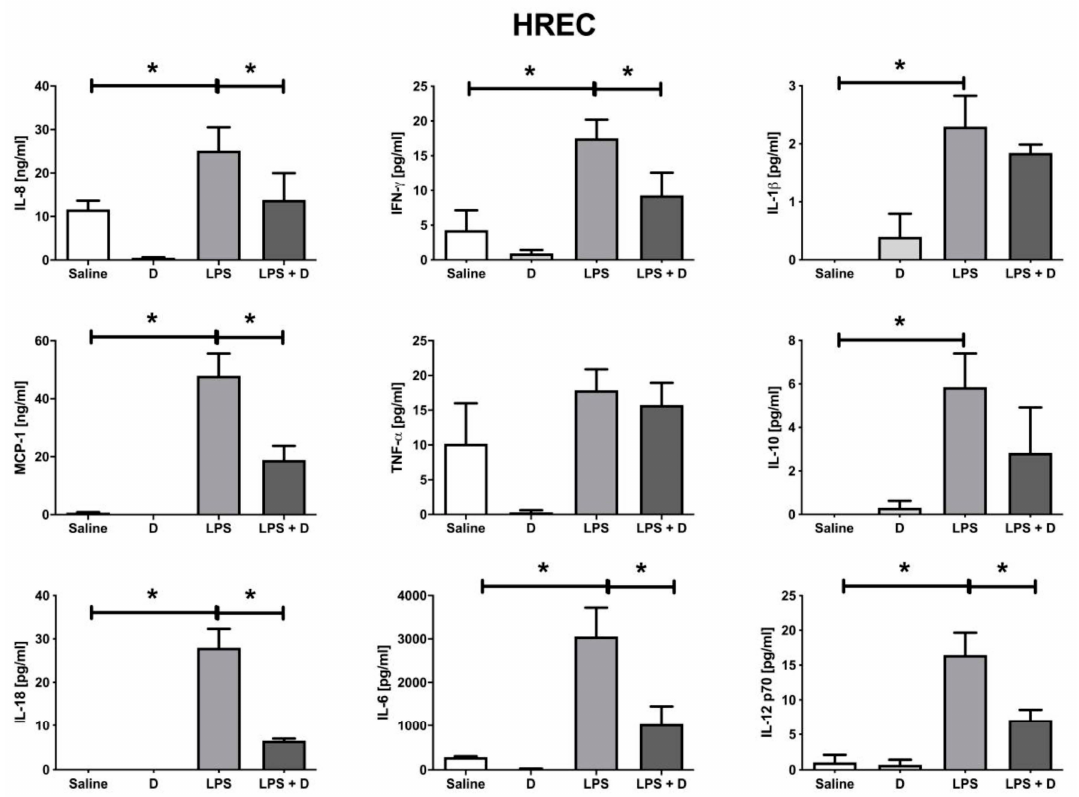
Figure 8. Multiplex inflammatory cytokine array in HREC cells. IL-8, IFN- γ , IL-1 β , MCP-1, IL-10, IL-6, and IL-12p70 inflammatory cytokine levels were increased by adding LPS (* p < 0.05), and IL-8, IFN- γ , IL-1 β , MCP-1, TNF- α , IL-6, and IL-12p70 levels were reduced (* p < 0.05) with the addition of VITD in concomitance. n = 3.